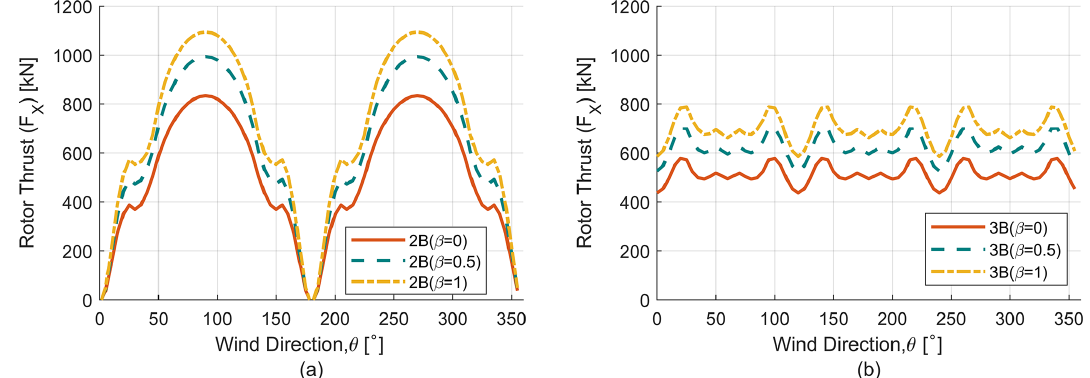
Figure 12. Parked thrust load ( F X ) analysis. (a) Parked thrust load ( F X ) for two-bladed (2B) rotors. (b) Parked thrust load ( F X ) for three- bladed (3B) rotors.